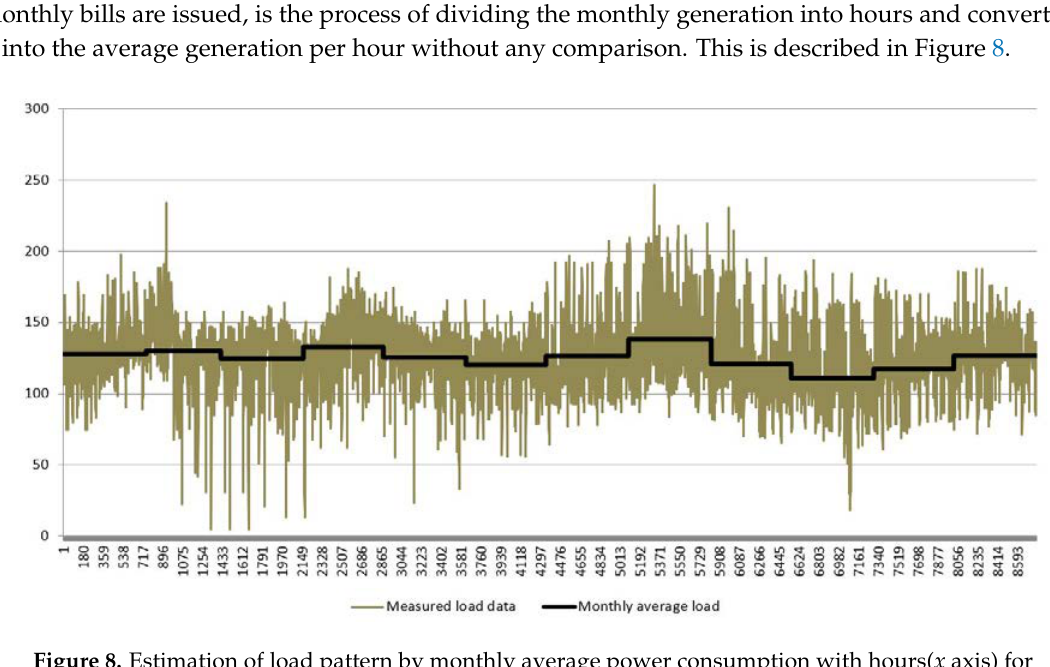
Figure 8. Estimation of load pattern by monthly average power consumption with hours( x axis) for 1 year.